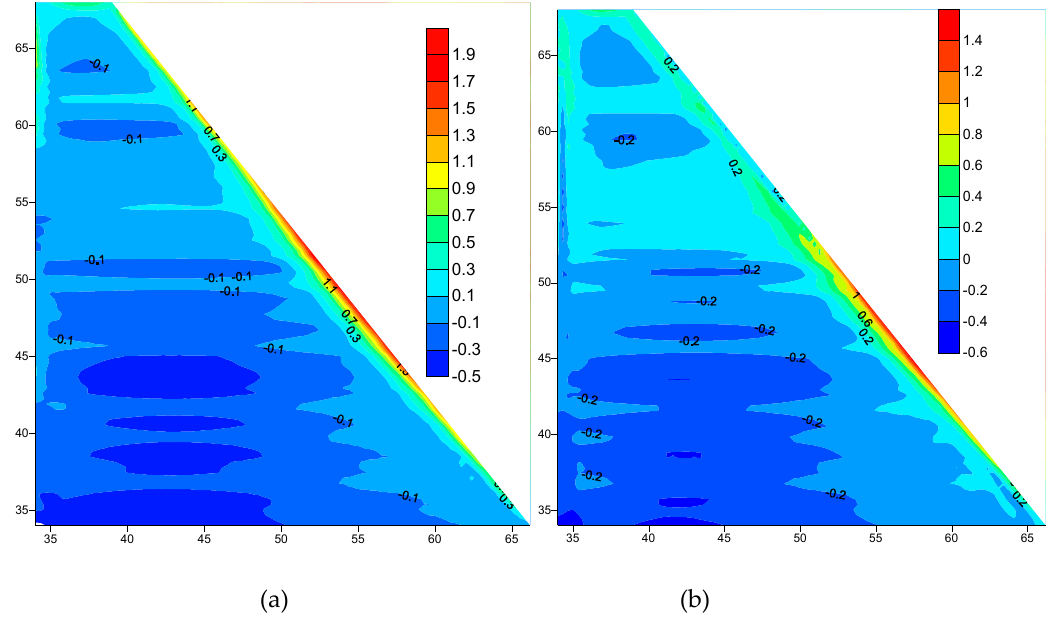
Figure 9. Maximum principle stress distributions with full reservoir during the second winter December 2018 (MPa): ( a ) Normal Placing Temperature, ( b ) Controlled Placing Temperature 20 °C.